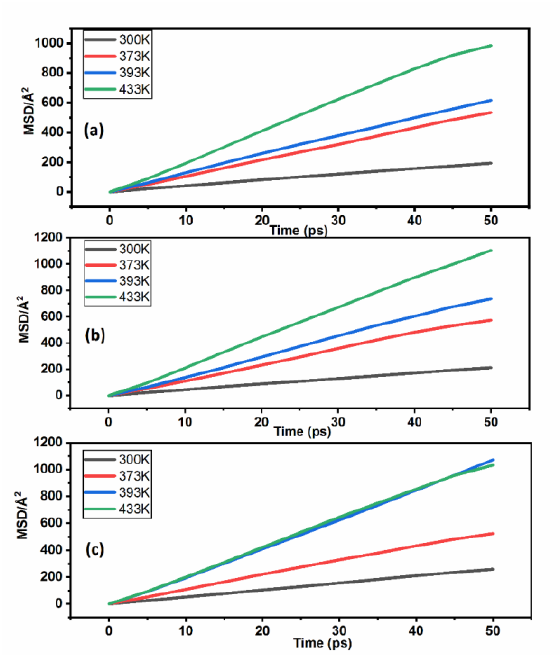
Figure 5. Temperature effect on diffusivity of SVOCs: a) CAP, b) MIC, c) NAPH in